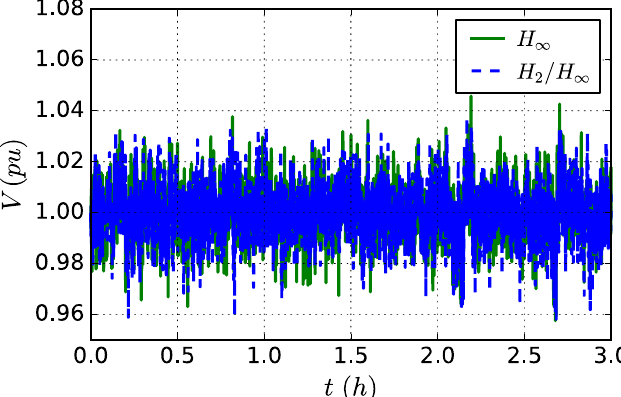
Figure 8. Power dynamics of diesel engine generators (DEG) under mixed H 2 / H ∞ control and H ∞ control schemes.